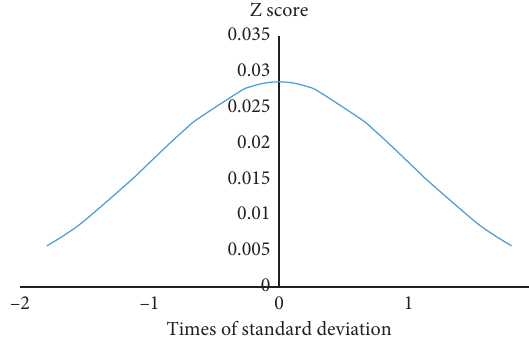
Figure 1: Distribution of ND data set.